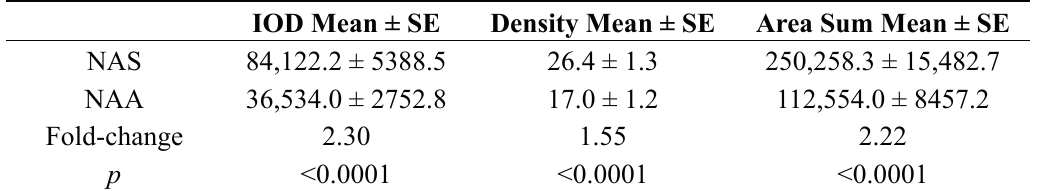
Table 5. The IOD, density mean and area sum values of AQP2 protein in NAS and NAA. IOD: integrated optical density, NAS: the East Asian finless porpoise, NAA: the Yangtze finless